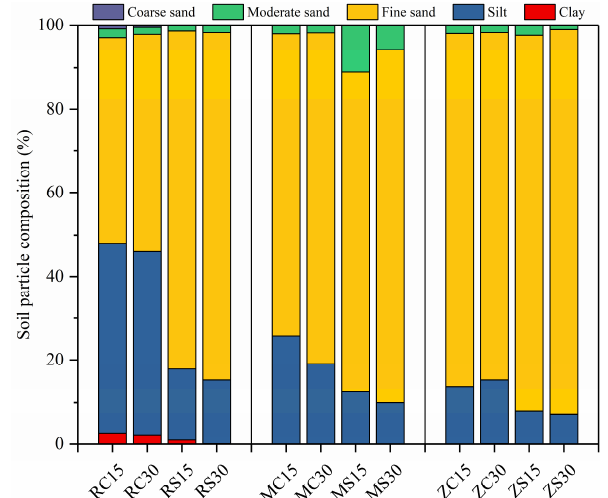
Figure 2. Soil particle size distribution of samples. Soil particle classifications: Clay (0–5 µm); silt (5–